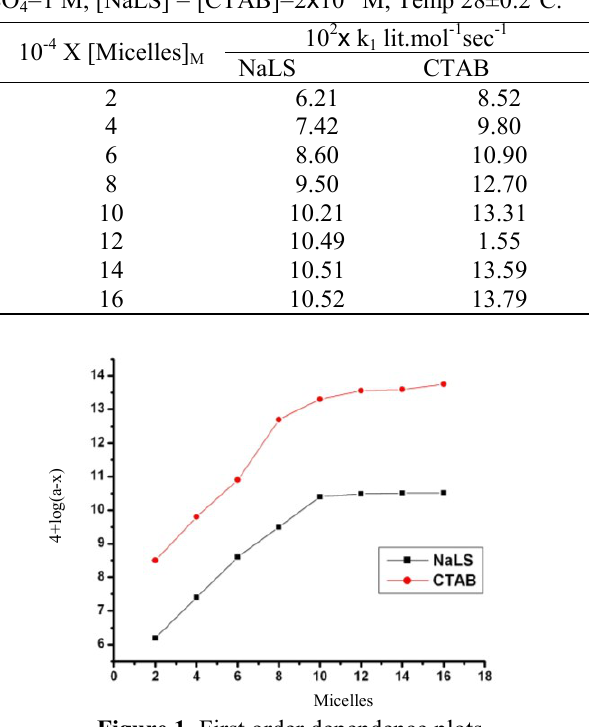
Table 5 . First order values for Mn(III)acetate of cobalt(III) bound Ligand. [(NH